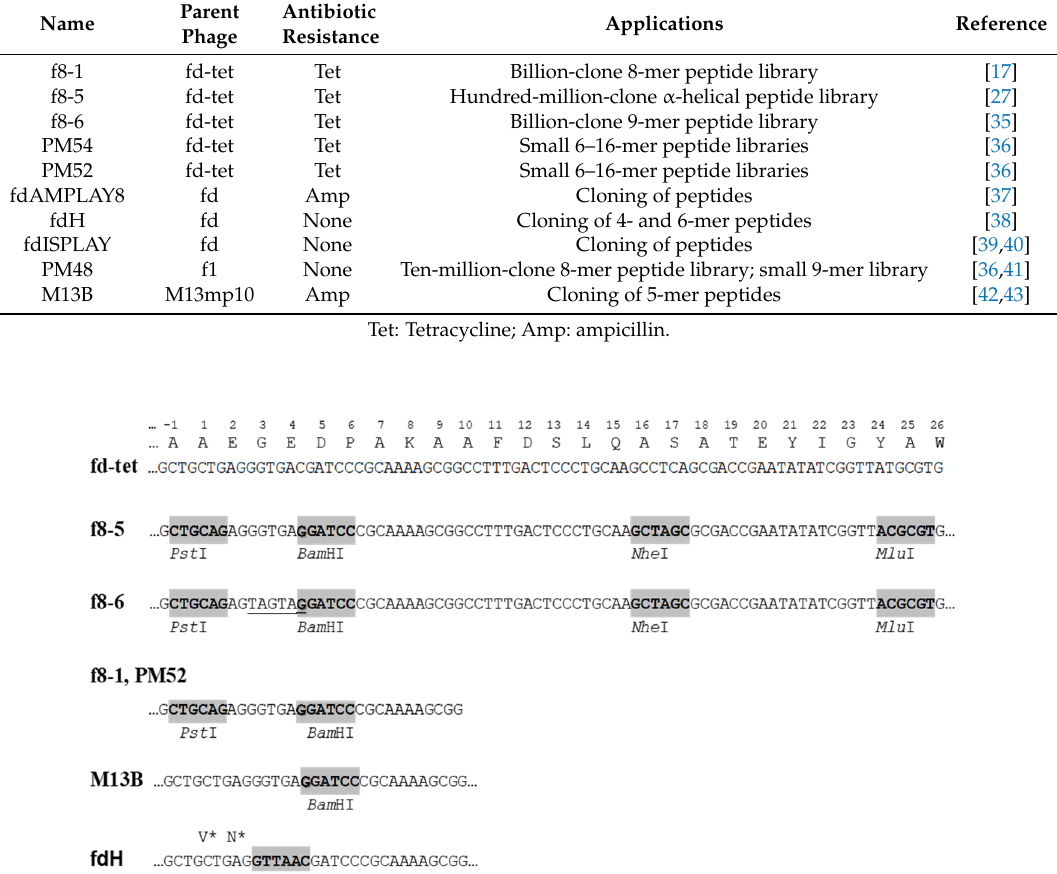
Table 1. Type 8 vectors.